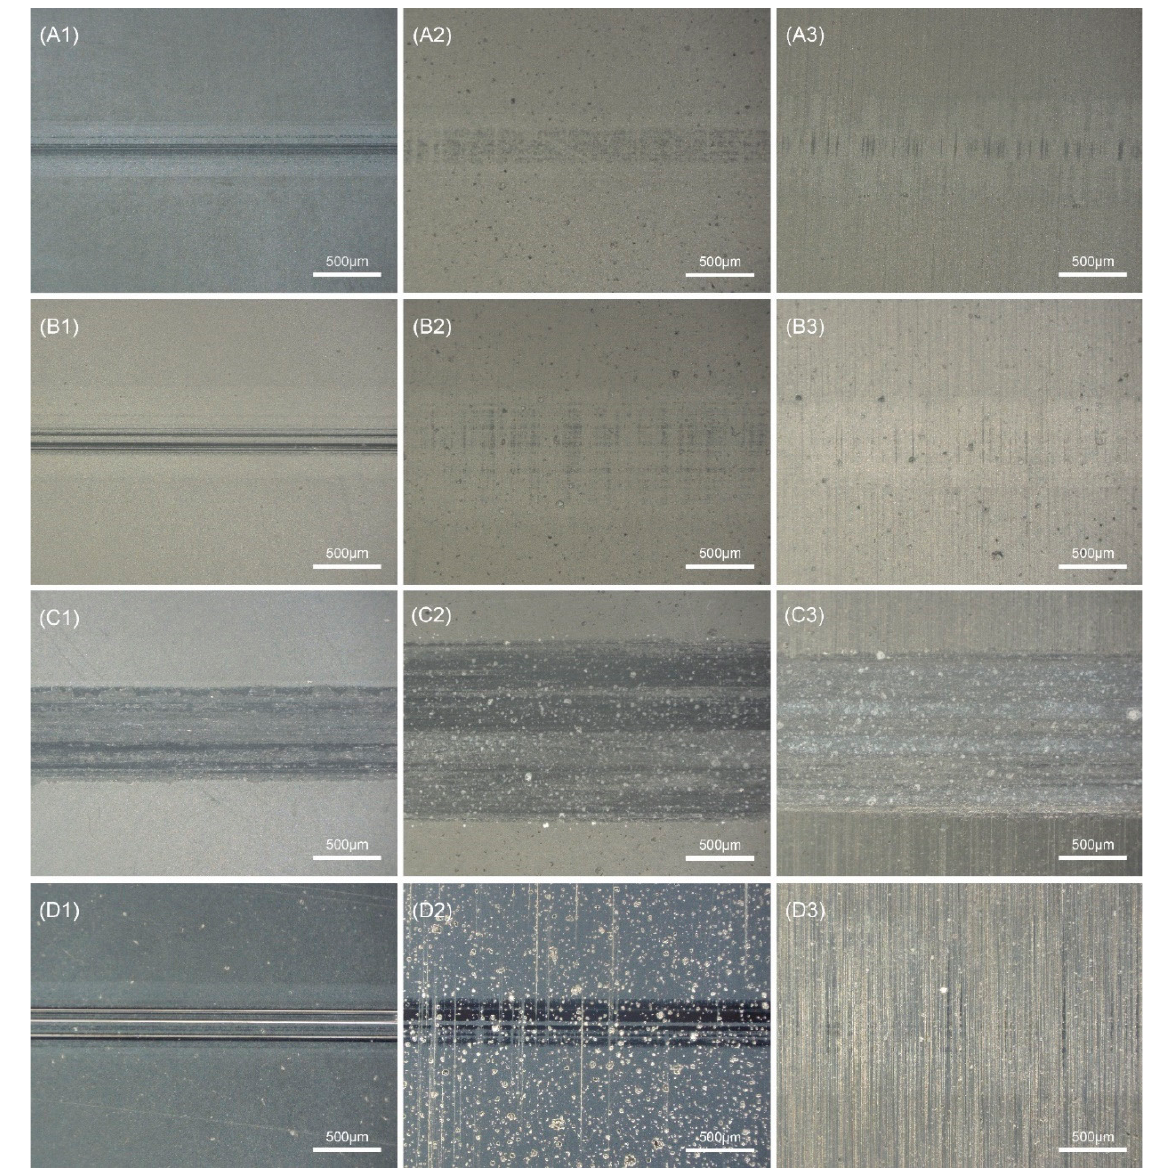
Figure 12. Wear tracks of diamond